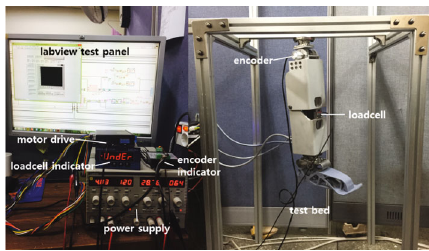
Table 6: Comparison between the desired and prosthetic leg speci fi